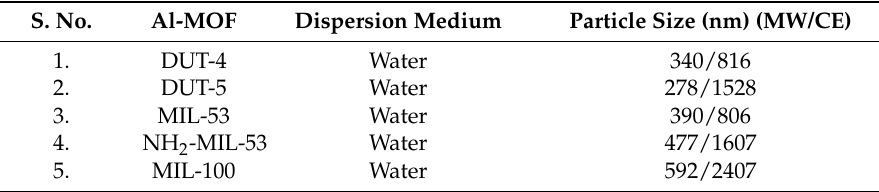
Table 1. Particle size values of Al-MOFs synthesized by MW and CE method.